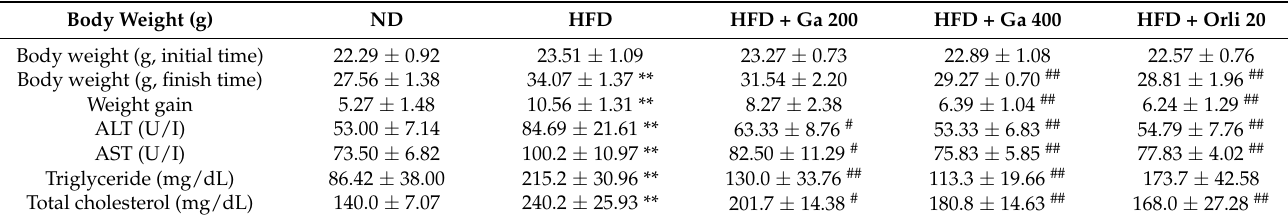
Table 1. Body weight and biochemical markers of animal models ( n = 7 per